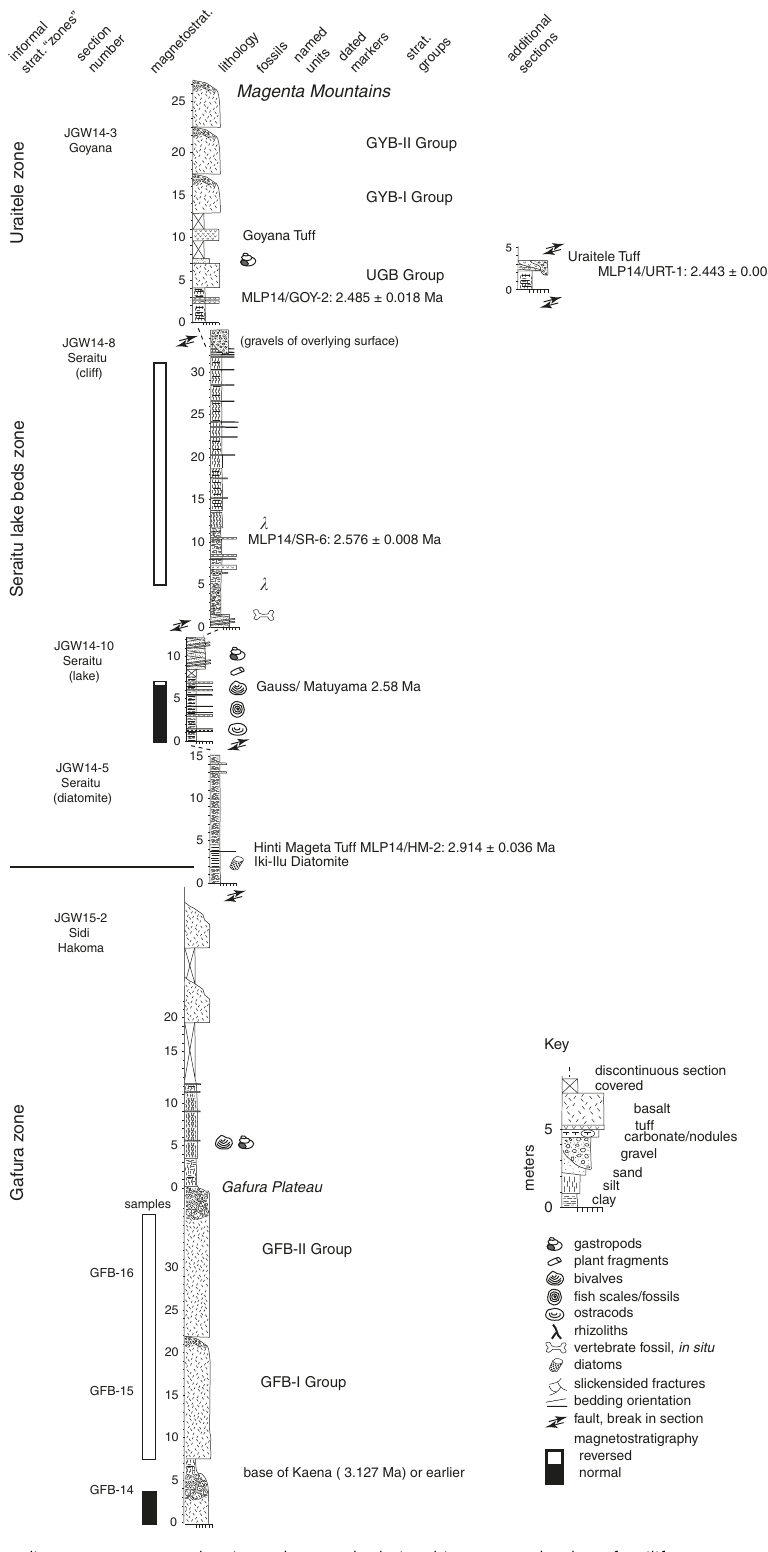
Fig. 2 Stratigraphic sections, sedimentary content volcanic markers, and relationships among the three fossiliferous zones (Gafura, Seraitu, and Uraitele) at the Mille-Logya Research